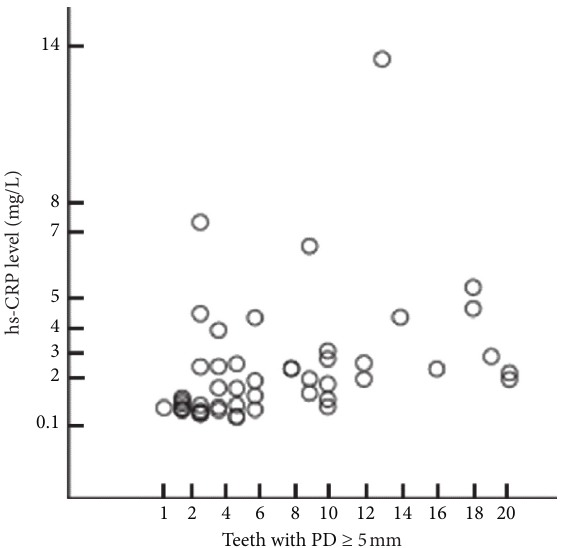
Figure 2: Matrix scatter plot of the number of teeth with ≥ 5mm PD and CRP concentration in all subjects. The number of teeth with ≥ 5mm PD was significantly associated with CRP concentration.